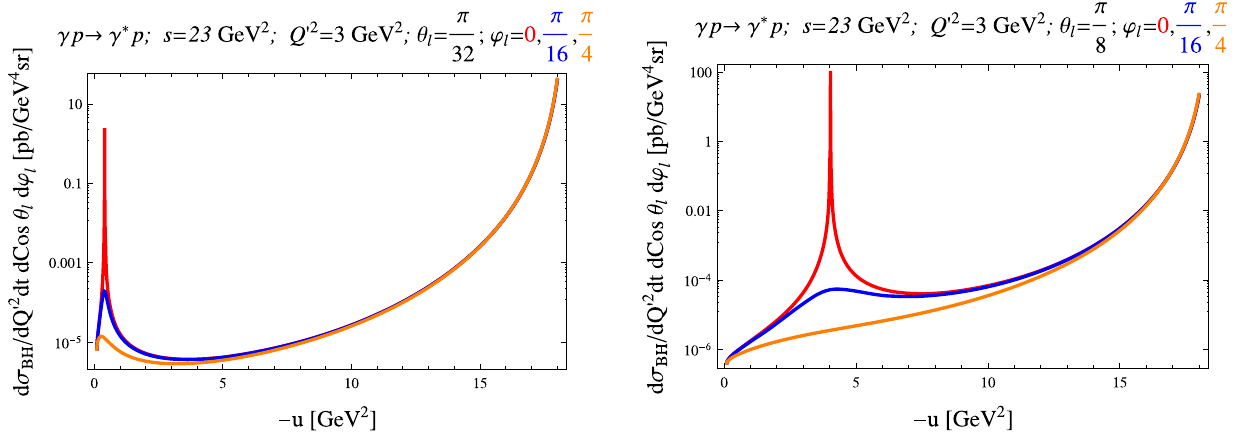
Fig. 5 The − u dependence of the Bethe–Heitler differential cross-section at θ (cid:6) = π/ 32 (left panel) and θ (cid:6) = π/ 8 (right panel) for various values of ϕ (cid:6) , at Q (cid:4) 2 = 3 GeV 2 and s = 23 GeV 2